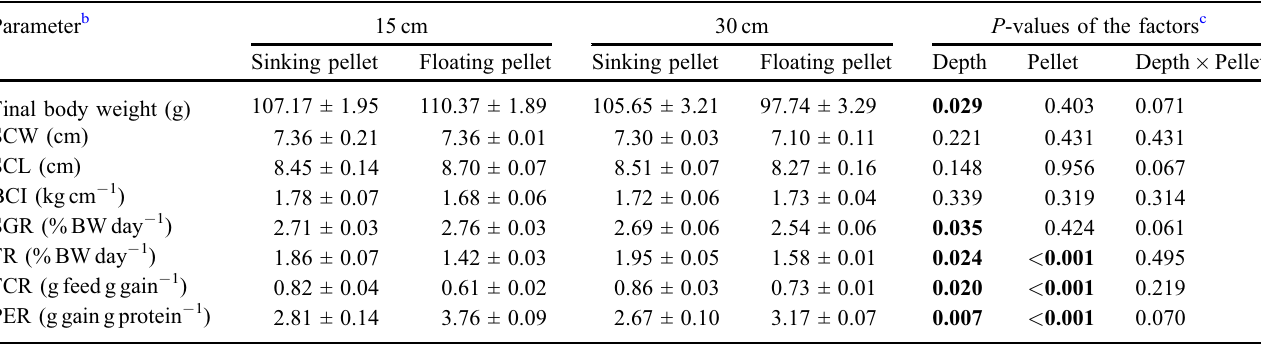
Table 2. Growth performance and feed utilization of post-hatching green turtles reared under different water depths (15 or 30 cm) and fed with commercial feed pellets (sinking or fl oating type). a The data (mean±SEM) are for turtles sampled at the end of the